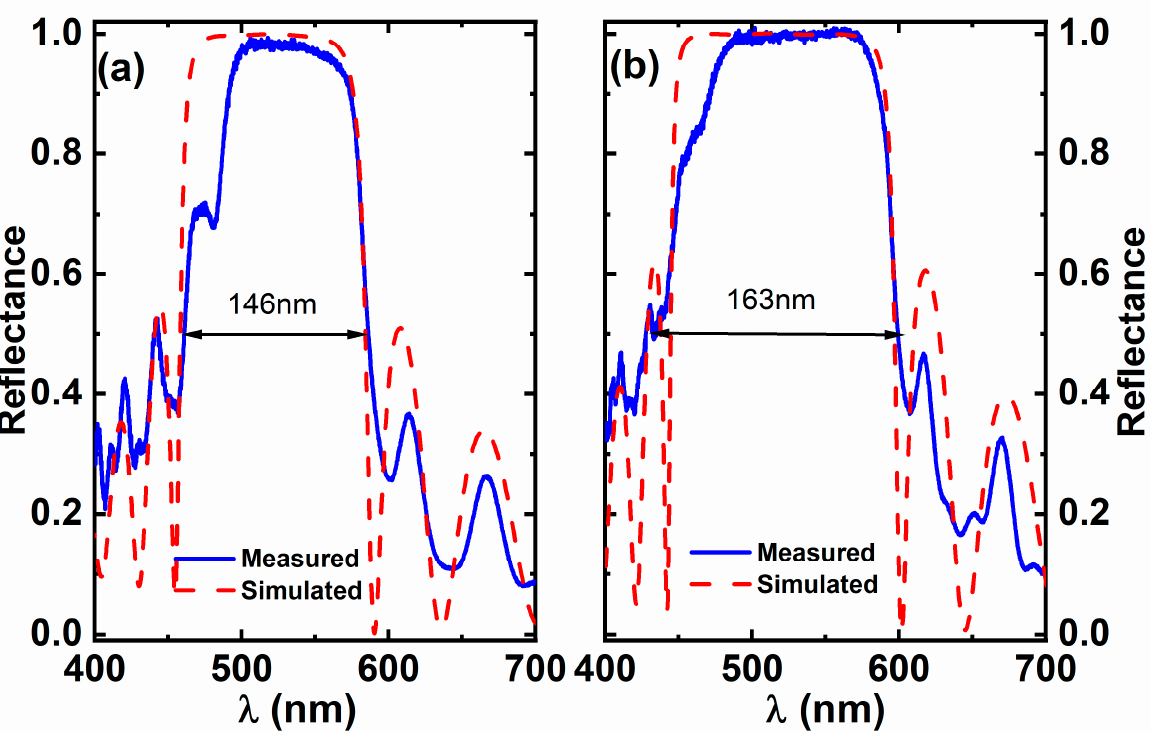
Figure 4. Reflectance spectra of ( a ) Sample A and ( b ) Sample B after EC etching, which were converted to the DBR structures.